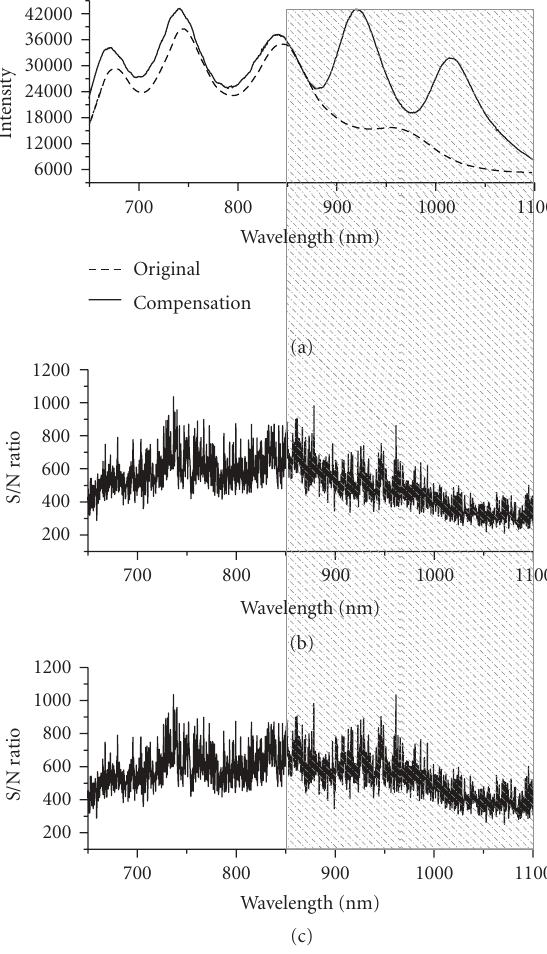
Figure 3: (a) Light source spectrum before and after compensation, (b) signal-to-noise ratio before compensation (c) signal-to-noise ratio after